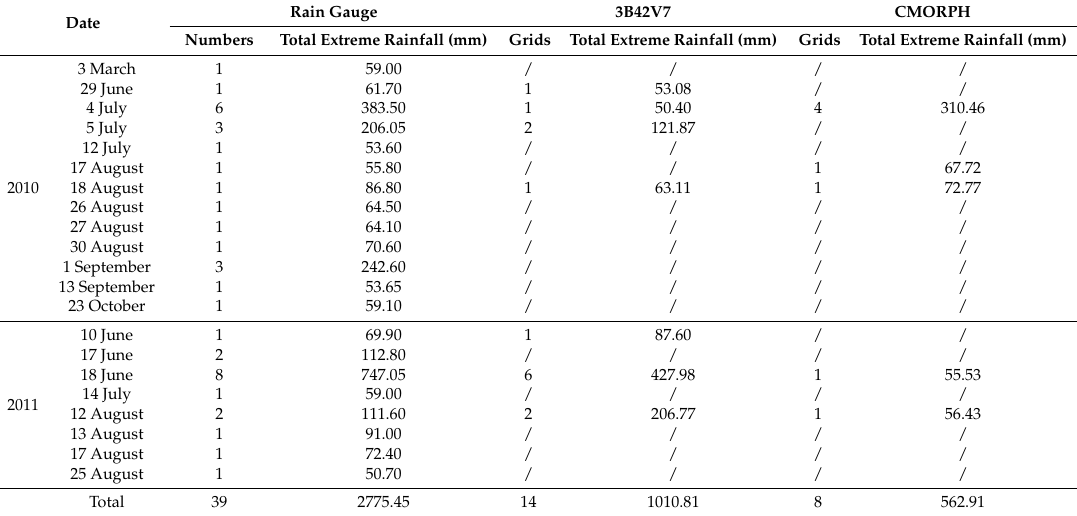
Table 4. The detection results of extreme rainfall events of the rain gauge, the 3B42V7, and CMORPH from 2010 to 2011.